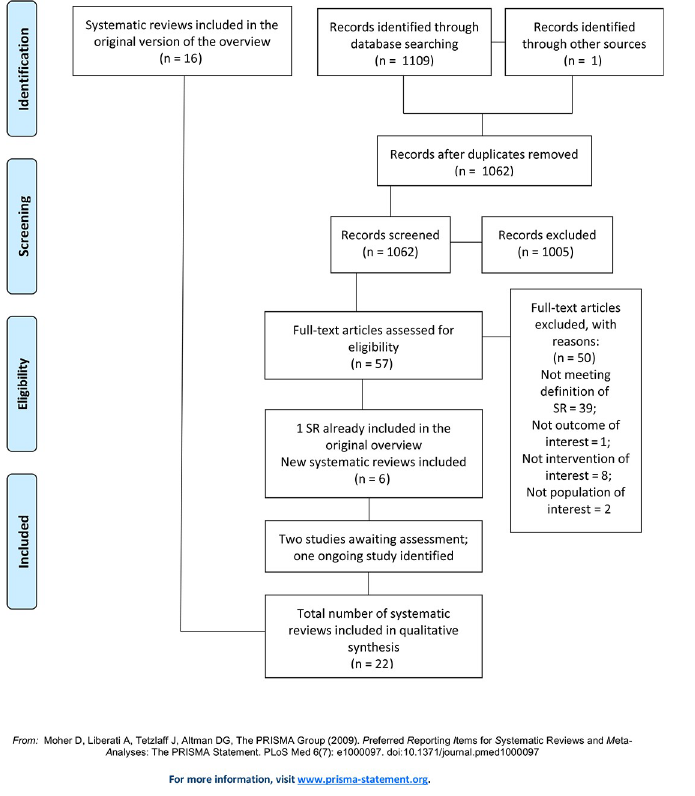
Fig 1. Flow diagram on the selection of systematic